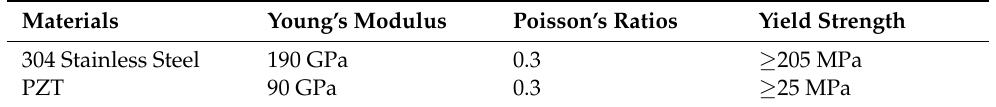
Table 2. Mechanical properties of